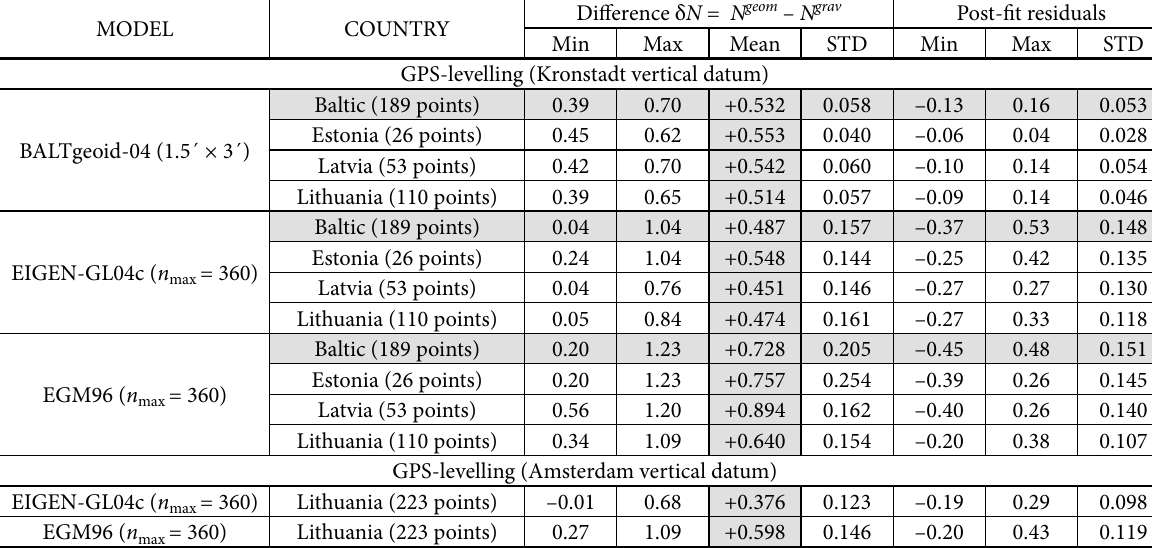
Table 3 . Numerical statistics of comparisons between the geoid models and GPS-levelling points. Units are in metres